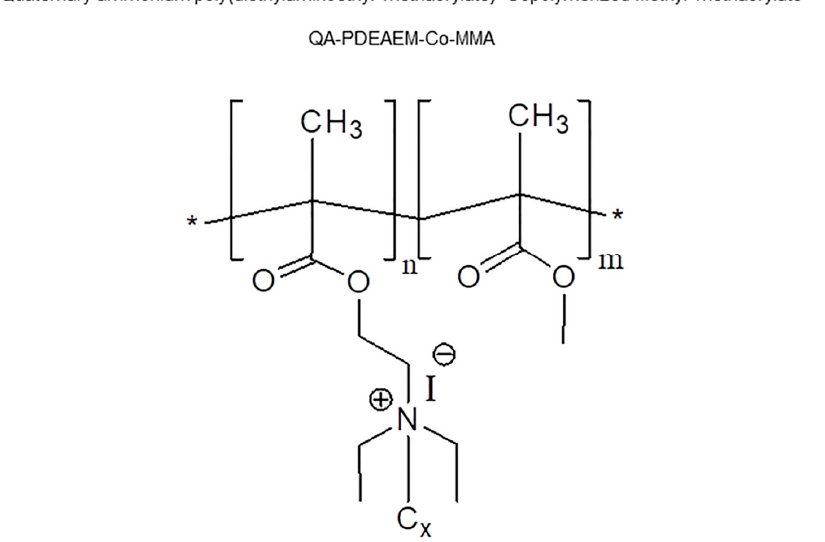
Figure 1. Chemical structures of the NPs anchored with DMAEMA and later copolymerized using different MMA concentrations. different MMA